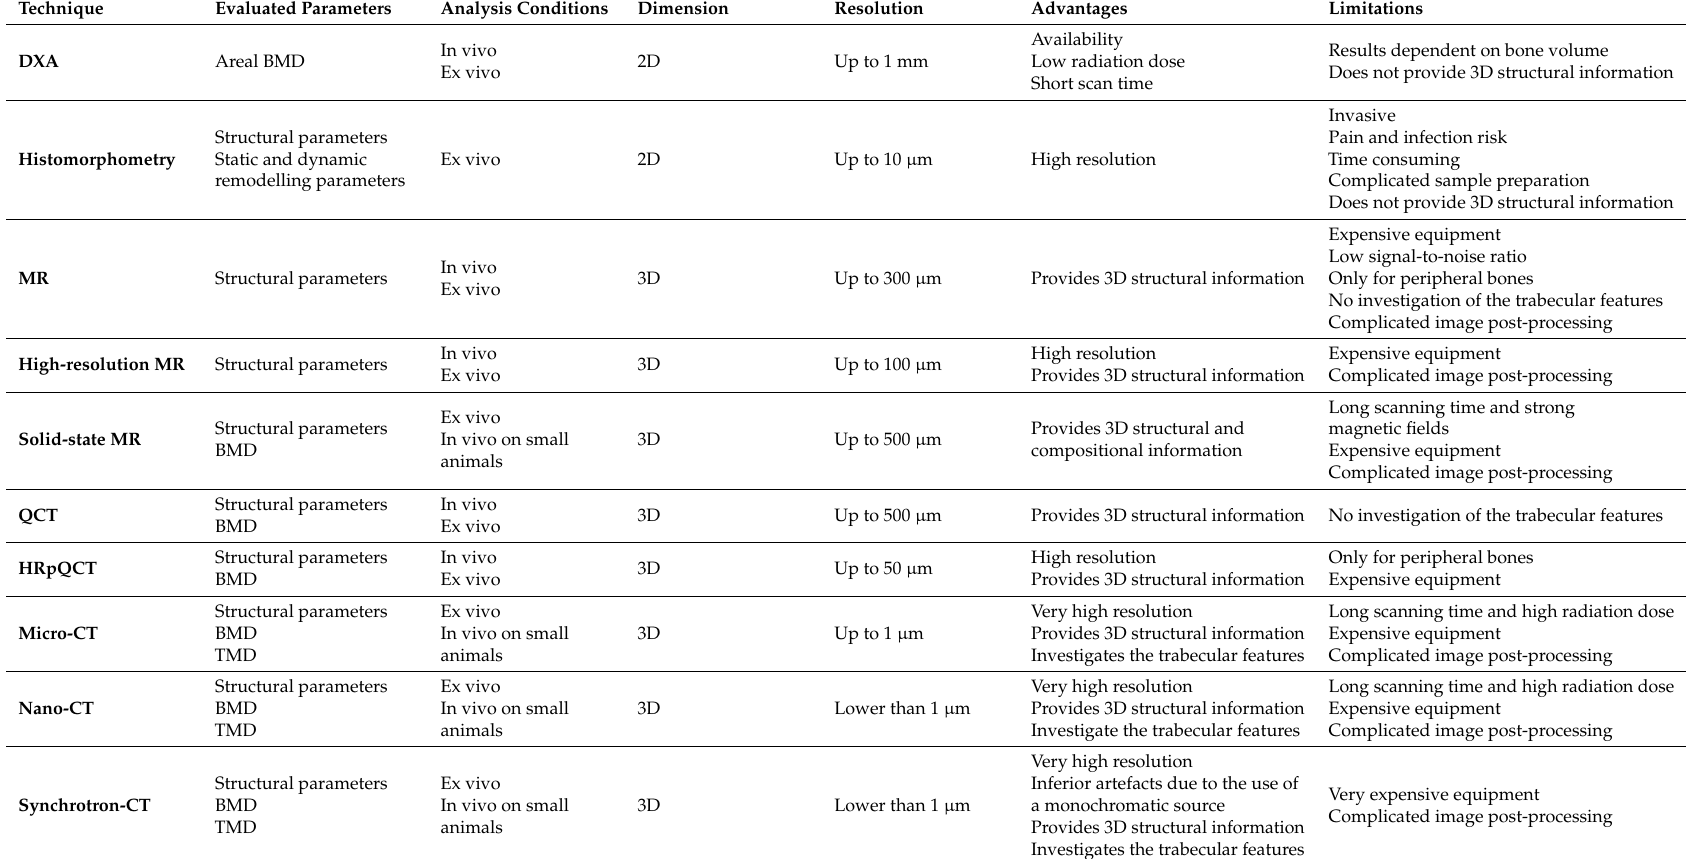
Table 1. Summary of the current imaging techniques for the study of bone tissue. Legend: dual-energy X-ray absorptiometry (DXA); bone mineral density (BMD); magnetic resonance (MR); quantitative computer tomography (QCT); high-resolution peripheral computed tomography (HRpQCT); tissue mineral density (TMD); computed tomography